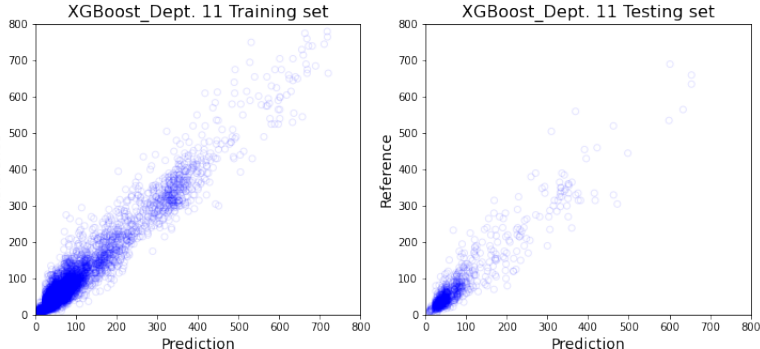
Figure A18. Model Performance of XGBoost on Dept.11. The visualization of training and testing data for department specific model on department 11 with